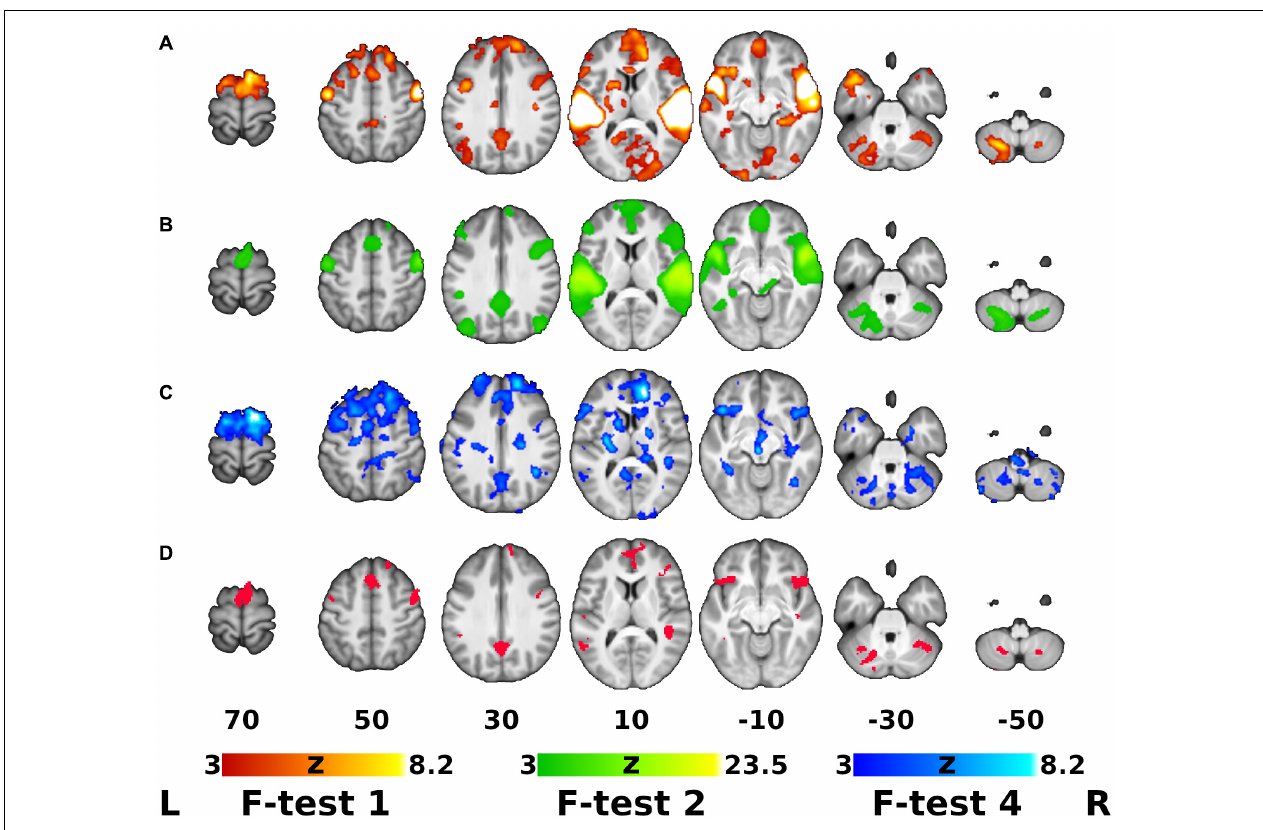
FIGURE 2 | Global F-test of the ANOVA Model, Overall Activation/Deactivation, Group-by-Time Interaction and the ROI Mask for Post hoc Analysis. (A–C) Thresholded Z-score (normalized F-statistics) maps on top of an average T1-weighted structural image. (A) Global F-test of the analysis of variance (ANOVA) model (F-test 1, red-yellow overlay). (B) Mean activation/deactivation map across all sound classes (F-test 2, green overlay). (C) Areas showing differential effect of training/time between the groups (Group-by-time interaction, F-test 4, blue overlay). (D) Binary region of interest (ROI) mask resulting from conjunction of maps A ∩ B ∩ C (red). Maps (A–C) were cluster-wise thresholded using corrected cluster significance of p < 0.05 and cluster-forming threshold of Z > 3.0. Right is right according to neurological